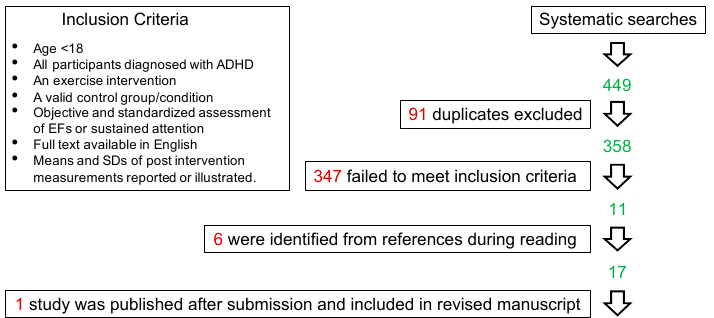
Figure A1. Flow-chart of the study selection process.